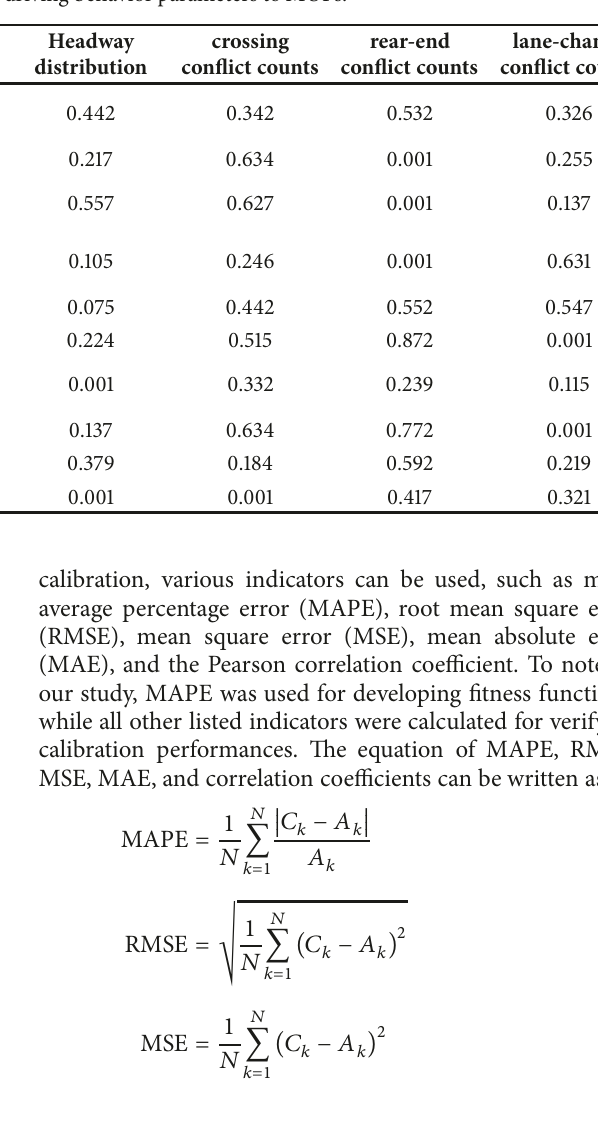
Table 2: ANOVA tests on sensitive driving behavior parameters to